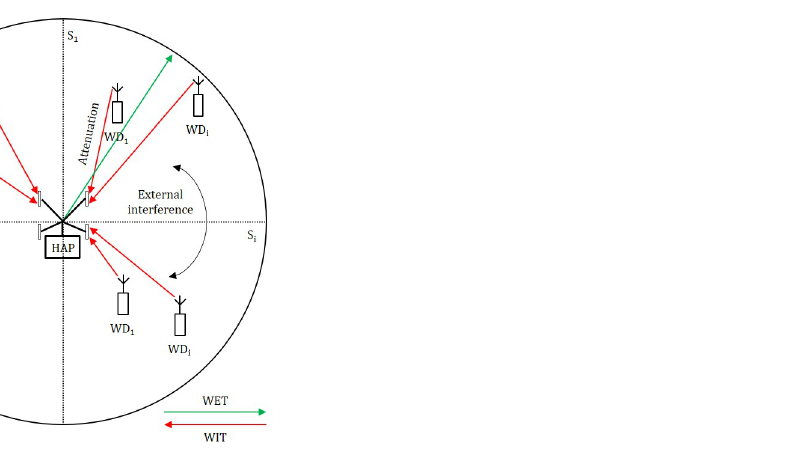
Figure 1. System model: hybrid SDMA and NOMA approach and optimal power allocation.